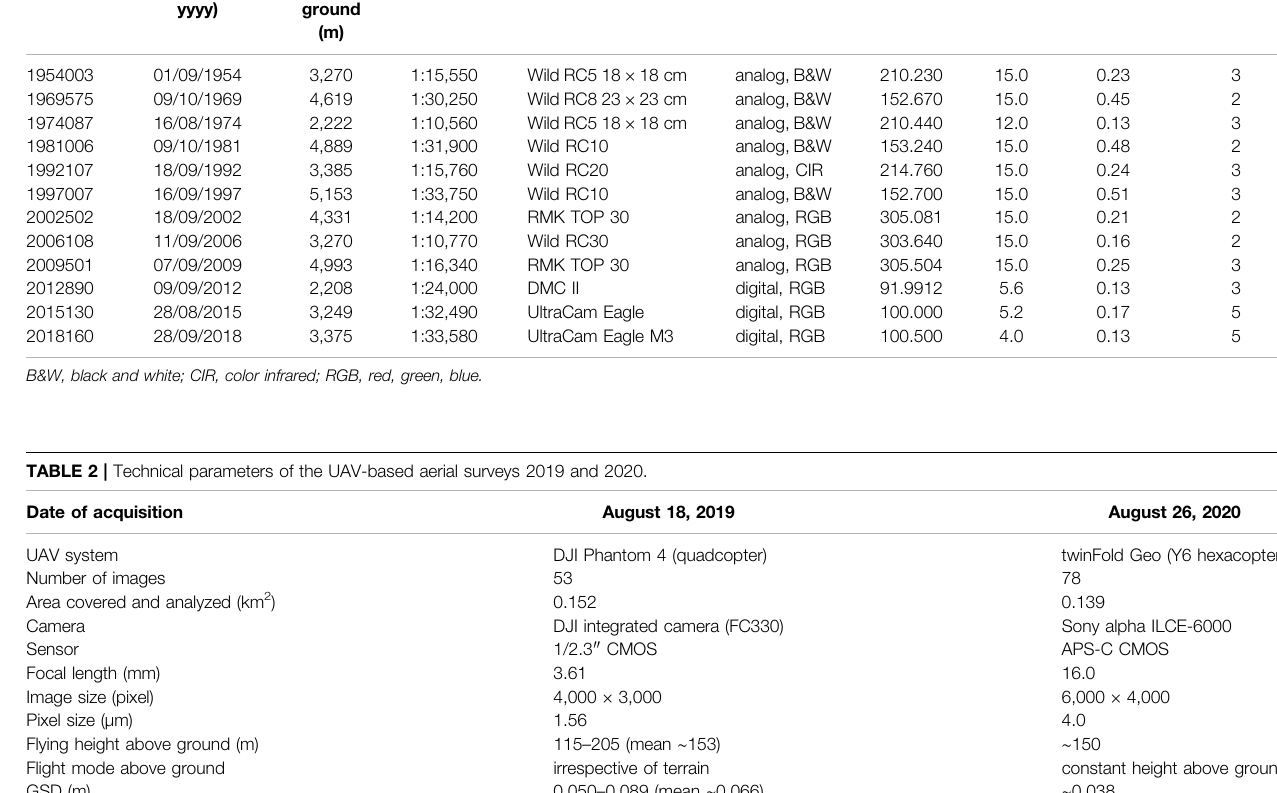
TABLE 1 | Technical parameters of the conventional aerial surveys 1954 – 2018.